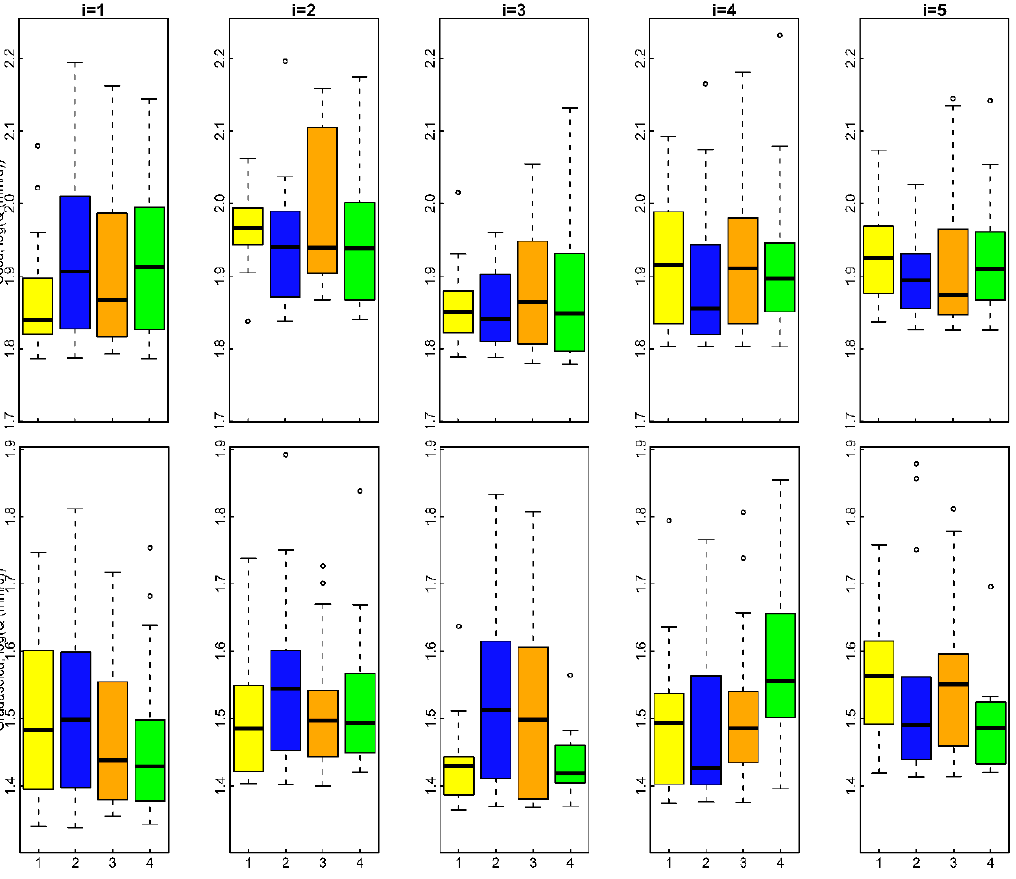
Figure 4. Box-plots of ROS-flood magnitudes for four investigated 30-year periods for two catchments and five GCM/RCM models. Box-plot colors indicate different periods (yellow: 1981–2010; blue: 2011–2040; orange: 2041–2070; green: 2071–2100).